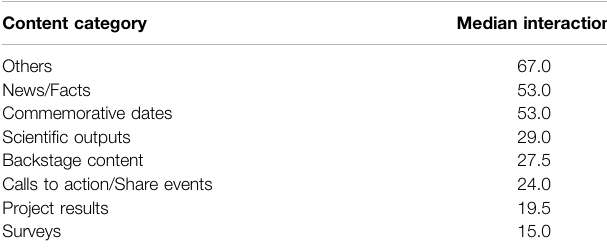
TABLE 3 | Engagement of Facebook posts assigned to different typologies. TABLE4| Engagement